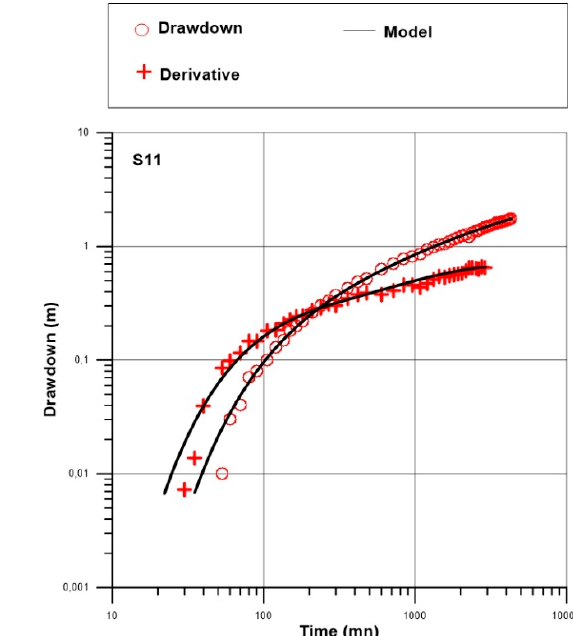
Figure 13. Interpretation of pumping test S10/S11: diagnostic plot ( left ) and data superimposed with a fitted Theis solution with an infinite linear no flow boundary located between 20 and 30 m from the pumping site ( right ).